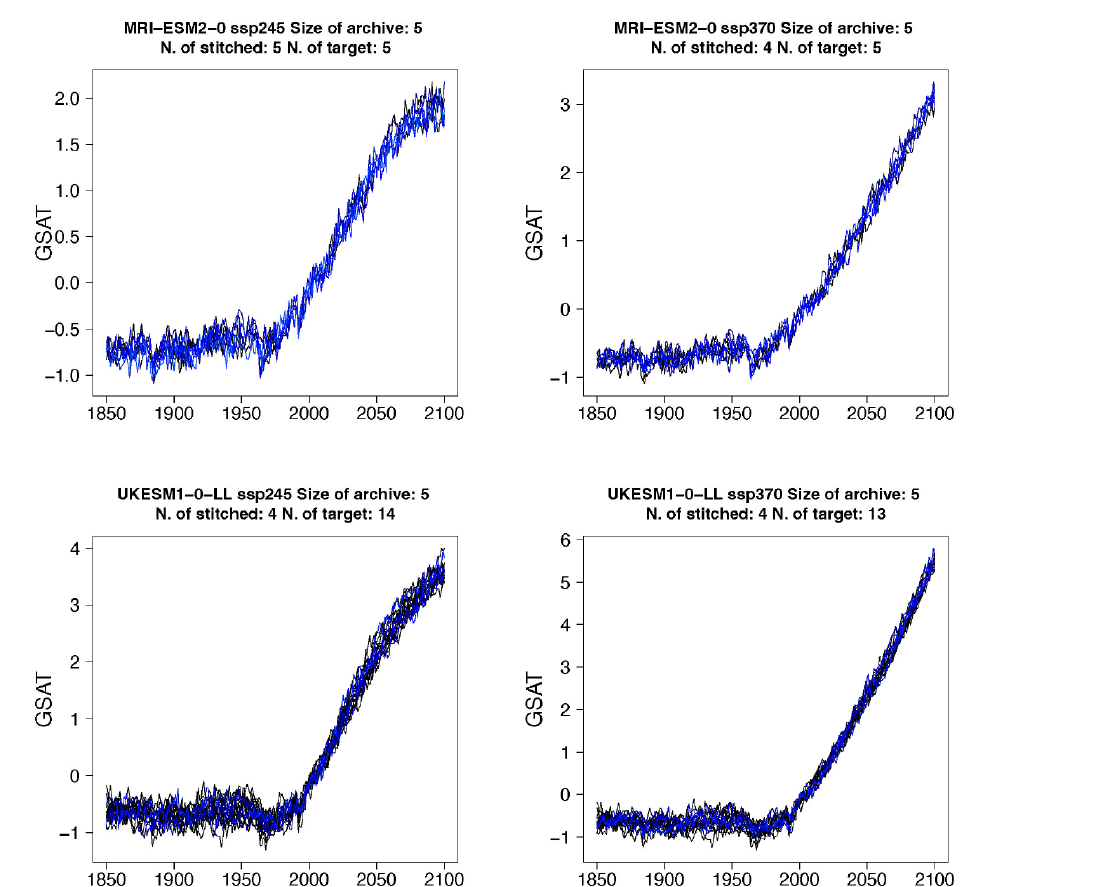
Figure E5. Examples of enriched ensembles of GSAT time series for ESMs in the PANGEO archive that have at least five trajectories available over the 21st century. As in the figures in Appendix A, warmer colors indicate a larger number of stitched trajectories in the figure, as the title also